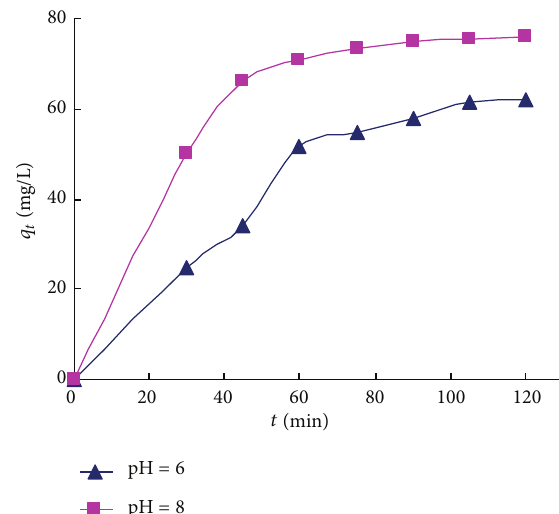
Figure 7: The effect of pH on the adsorption kinetics.